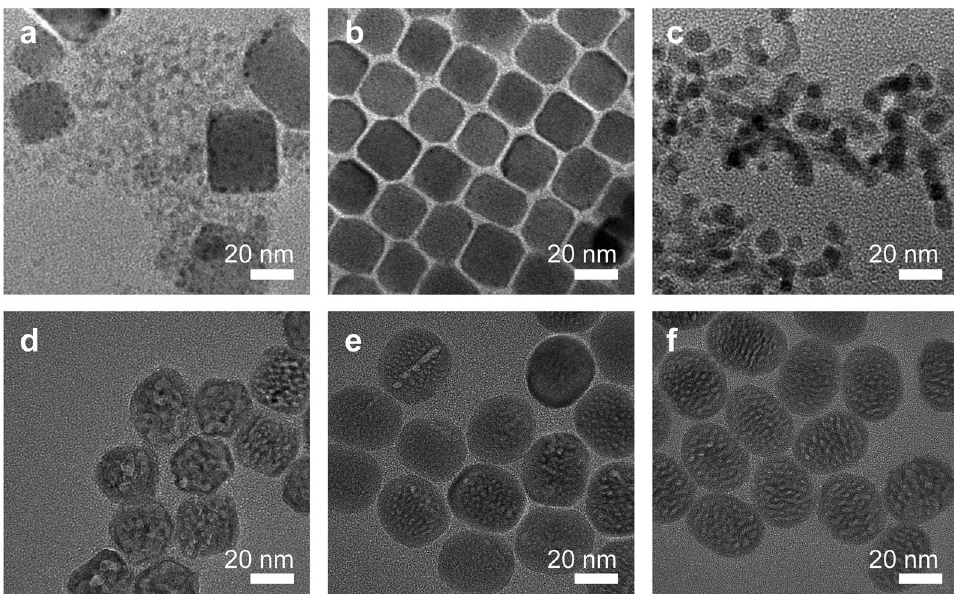
Fig. 2 Nanocrystal heterostructure formation during heat treatment. TEM images of heterostructured CsPbBr 3 – NaYF 4 : Yb,Tm nanocrystals collected during the synthesis at different temperatures. a 150 °C, b 200 °C, c 250 °C, d 300 °C — 0 min, e 300 °C-30 min, f 300 °C — 60